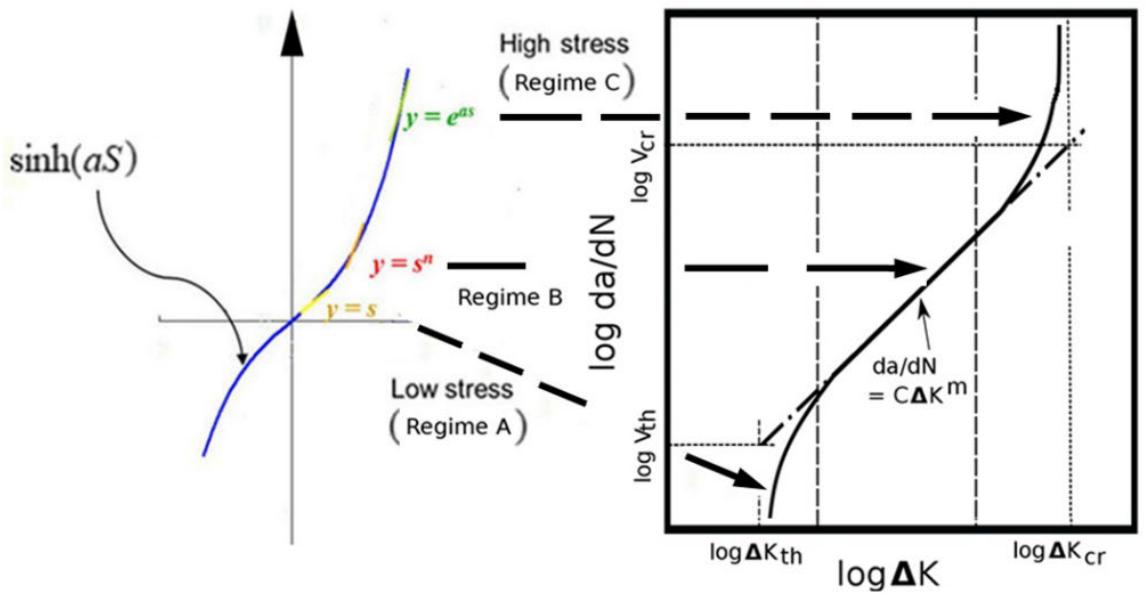
As the stress quantity in the structural components is hard to calculate in parametric ALT, Equation (18) is required to state again. Because the power for numerous energy areas is expressed as the process of combining flows and effort, stresses start from effort in an energy transport system (Table 2)